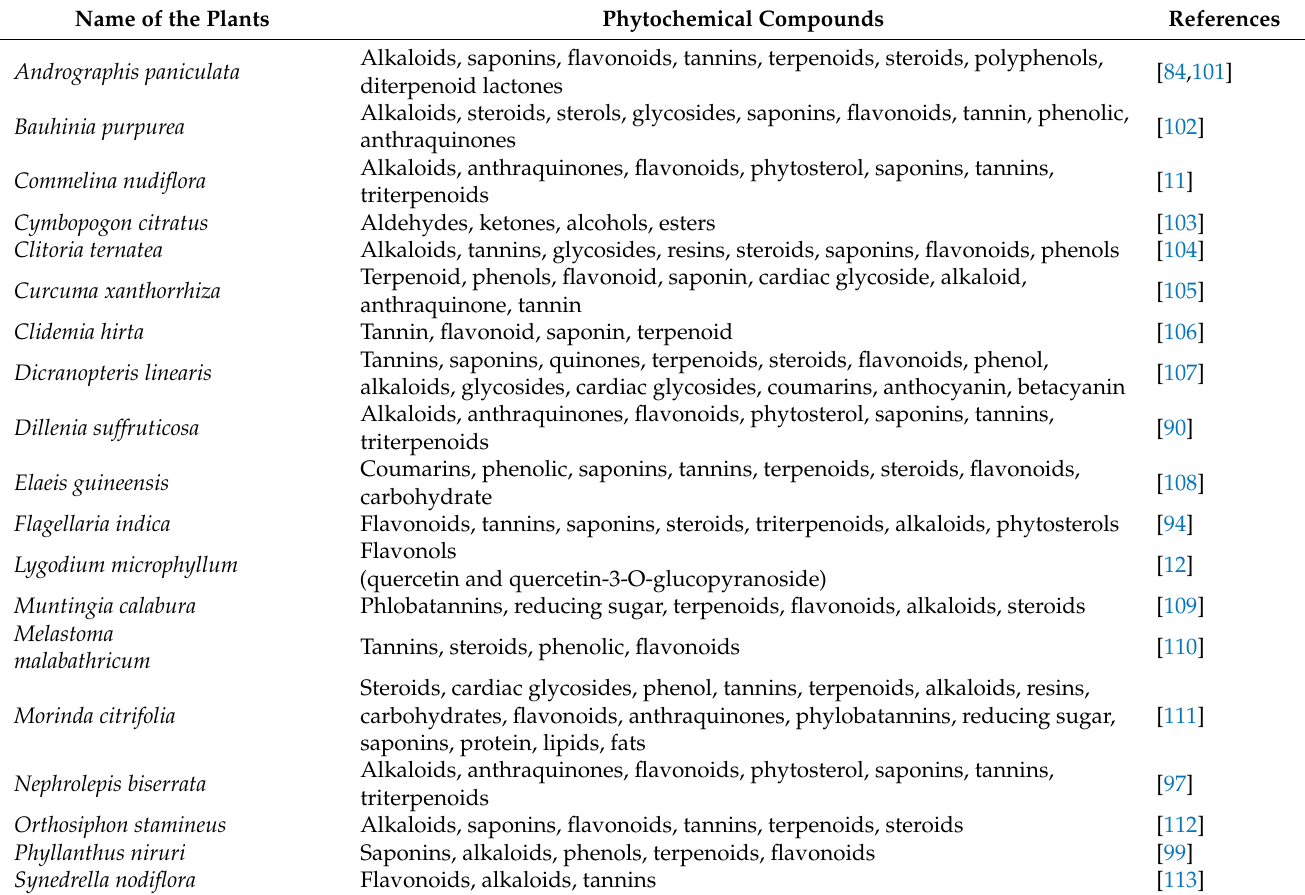
Table 1. The phytochemical compounds of Malaysia hepatoprotective plants.